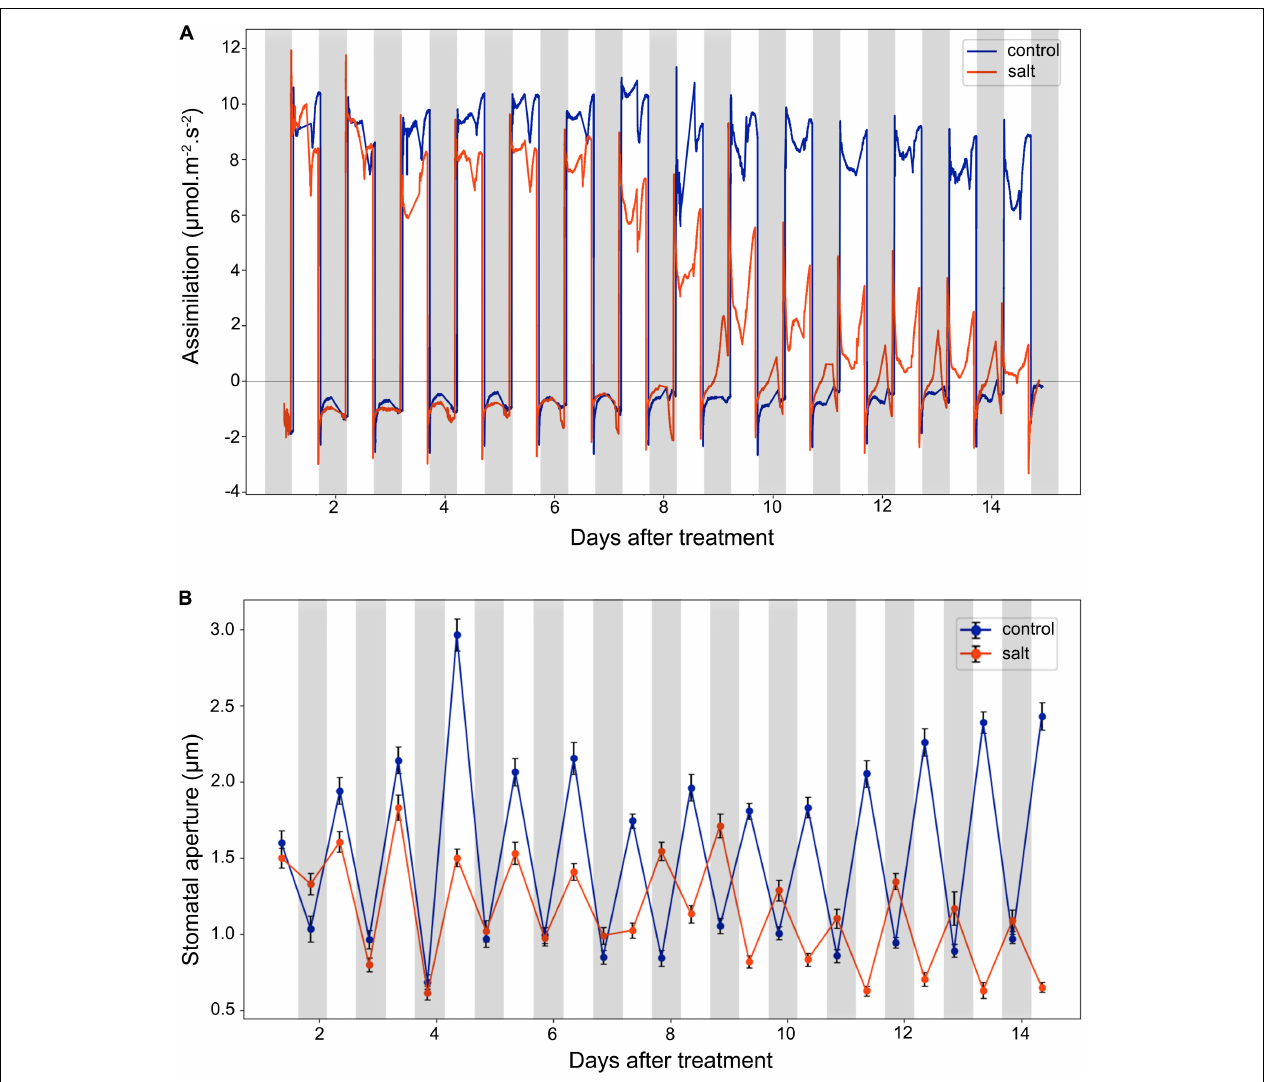
FIGURE 3 | Leaf CO 2 assimilation and stomatal aperture changes in the control and salt-treated M. crystallinum seedlings. (A) Leaf CO 2 gas exchange and (B) stomatal movement behavior. The blue line represents the control group and the orange line represents the salt-treated group. The gray bars represent the night time and the white bars represent the day time. The error bar represents standard error. The data were obtained from three biological